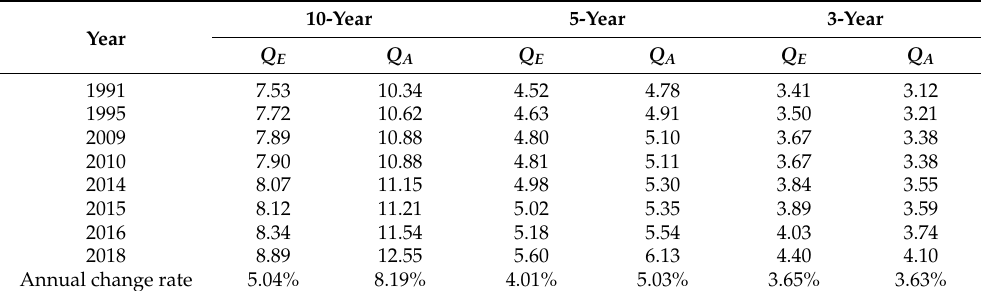
Table 3. Drainage coefficient under discharging 1-day rainfall in 2 days with different return periods (mm/d).